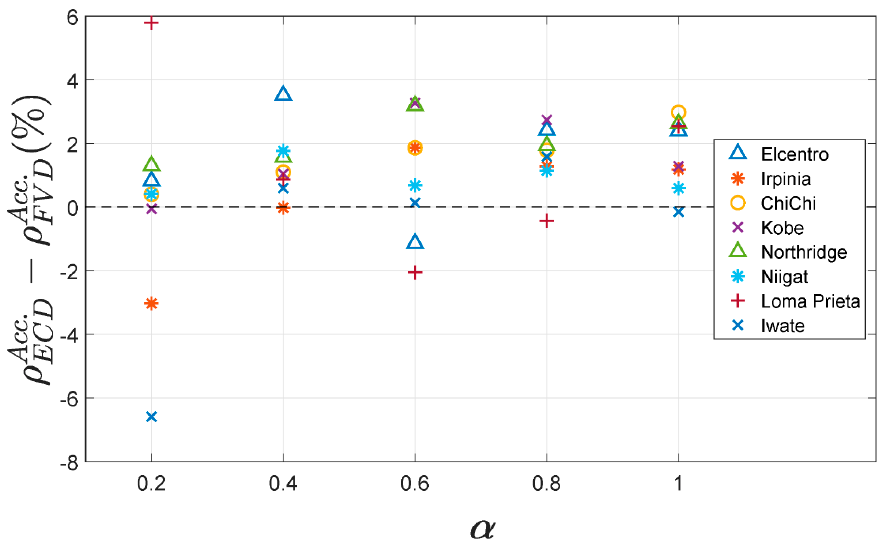
Figure 10. Acceleration reduction ratios under di ff erent